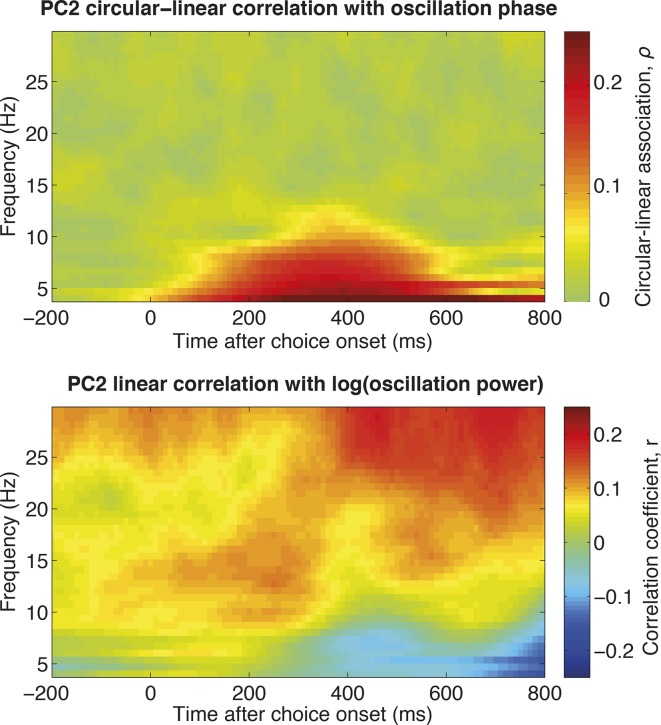
The relationship between single-trial PC2 weights and single-trial time-frequency decomposition (estimated across all electrodes in DLPFC).The top panel shows the circular-linear correlation (Berens, 2009) between the phase of the LFP in each frequency band for each timebin, and the PC2 weight for the corresponding trial. Note that this measure is non-negative by definition. This indicates that,as expected if PC2 alters the latency of a slow evoked potential, single-trial PC2 weights correlate with the oscillation phase in the theta range. The bottom panel shows the correlation coefficient between the power in each frequency band for each timebin , and the PC2 weight for the corresponding trial. This suggests a positive relationship between single-trial PC2 weights and high beta/low gamma oscillations late in the decision period.